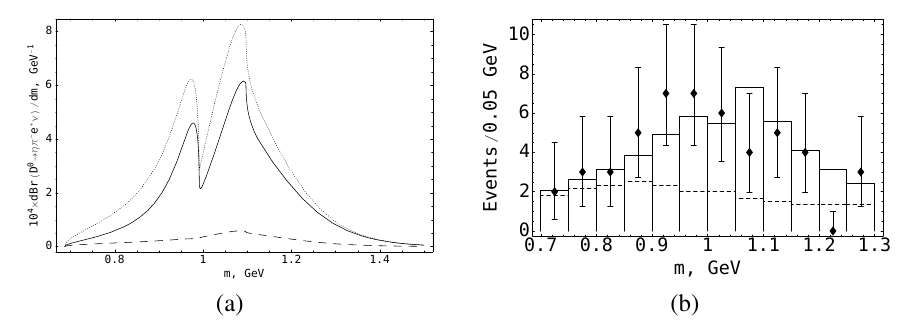
Figure 4. (a) The plot of D 0 → ( a − line is the total contribution, the dotted line is the term ∼ F a (cid:48)− dashed line is the term ∼ F a (cid:48)− ηπ − e + ν decay and our fit. The solid histogram is the total contribution, and the dashed histogram represents the sum of backgrounds.